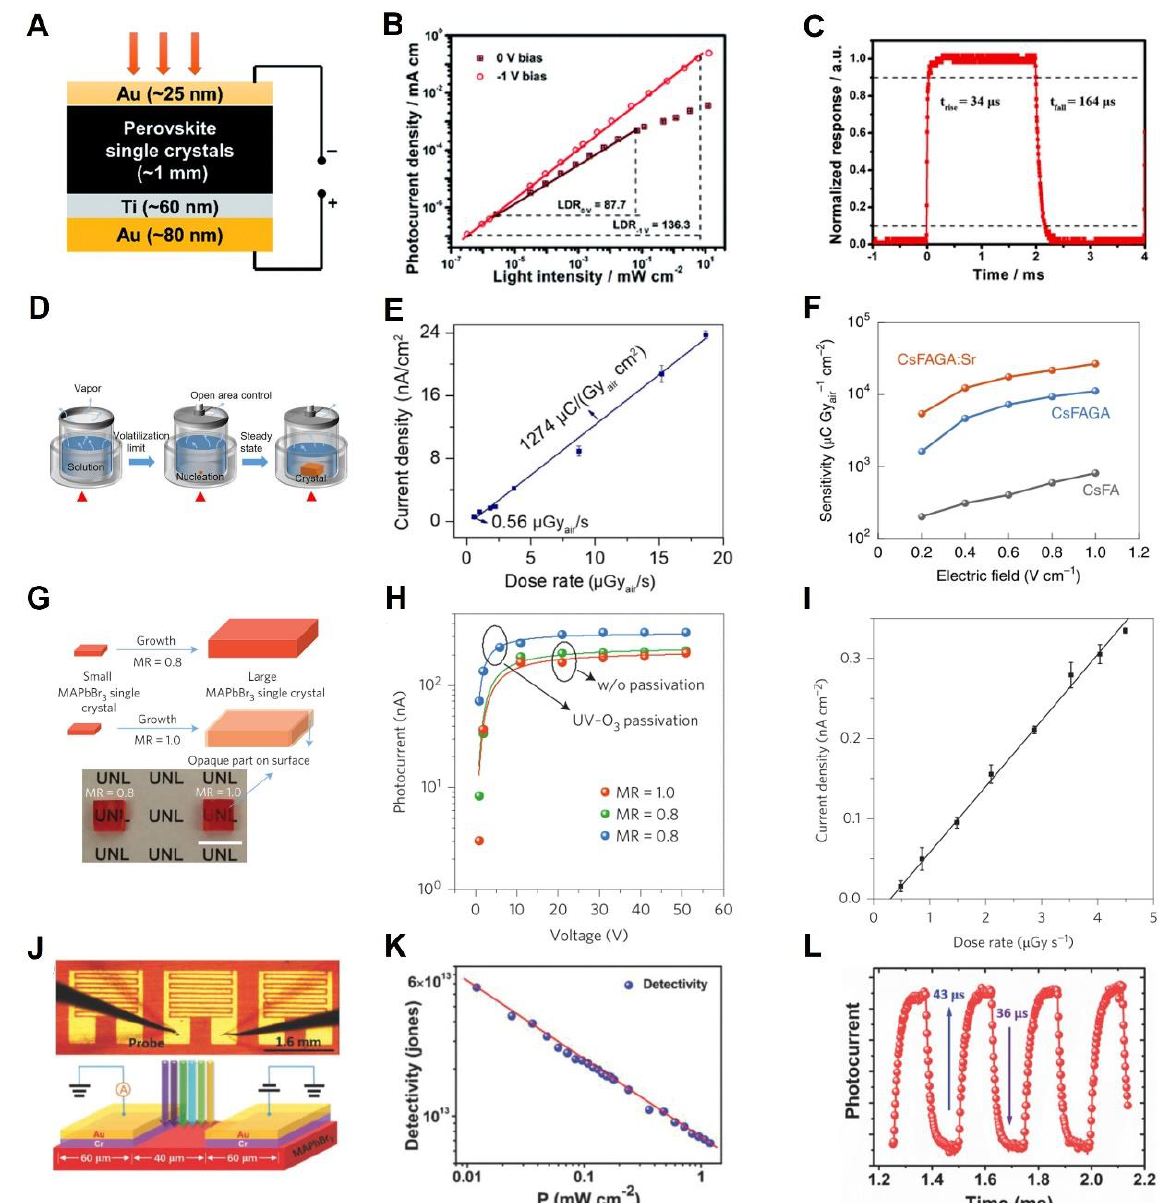
Figure 3. ( A ) Structure diagram of a perovskite single crystal detector. ( B ) LDR of the device at different bias voltages. ( C ) Transient photocurrent response of the single crystal detector [39]. Copyright 2017, Royal Society of Chemistry. ( D ) Schematic diagram of the device for growing a single crystal by changing the open area. ( E ) Changes in the current density of the detector at different dose rates [40]. Copyright 2021, Science Bulletin. ( F ) Plot of sensitivity and electric field for different single − crystal detectors [41]. Copyright 2022, Nature Publishing Group. ( G ) Single − crystal growth images under different molar ratio conditions (MR = PbBr 2 /MABr). ( H ) Device diagram of photocurrent and voltage for different MR and ozone treatment conditions. ( I ) Relationship between current density and dose rate of the device [42]. Copyright 2016, Nature Publishing Group. ( J ) Structure diagram of a single crystal sensor array device. ( K ) Relationship between incident optical power and detection rate of the sensor at a bias voltage of 4 V. ( L ) Transient photocurrent response curve of the sensor [43]. Copyright 2018, Wiley.